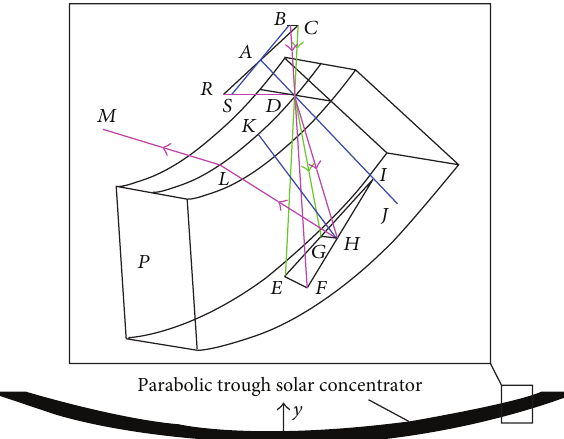
Figure 3: The main sunlight path for parabolic trough solar